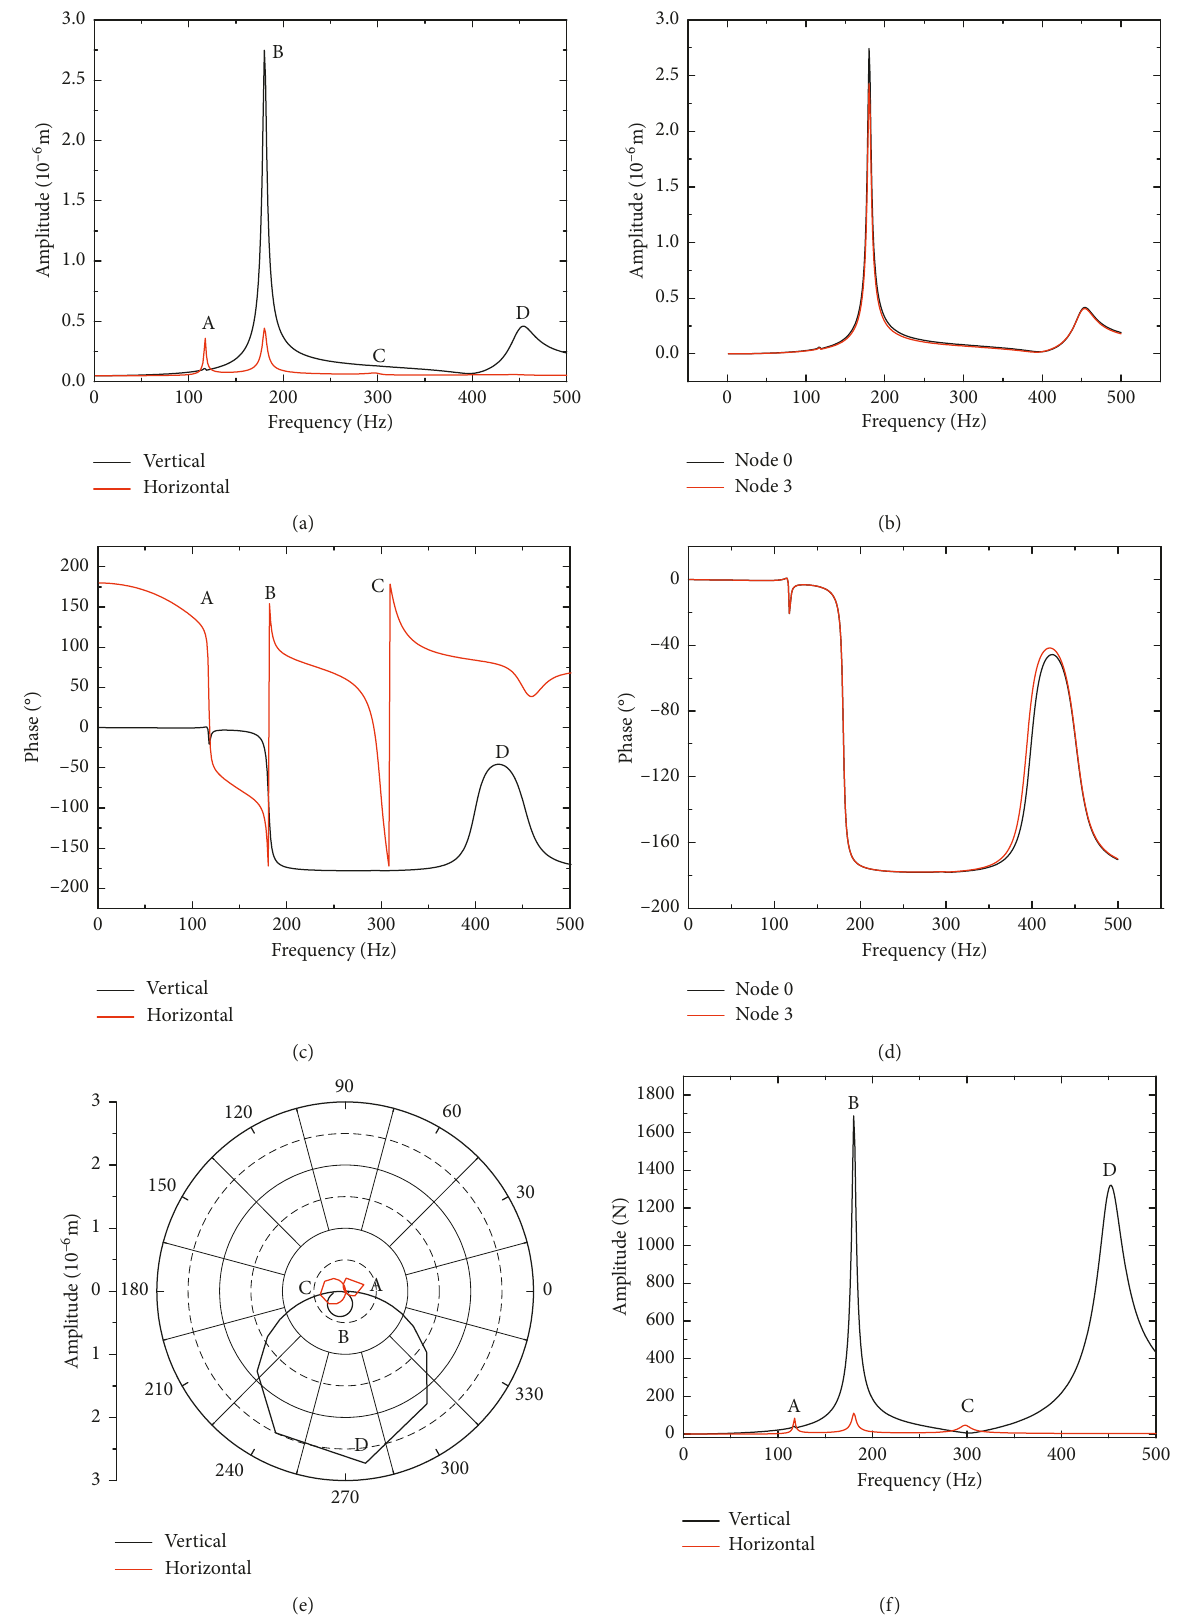
Figure 15: Rotor response and support reaction characteristics for condition 4 (anisotropic bearing stiffness). (a) Amplitude response at node 0. (b) Amplitude response for vertical direction. (c) Phase response at node 0. (d) Phase response for vertical direction. (e) Polar diagram at node 0. (f) Support reaction for bearing 1 at node